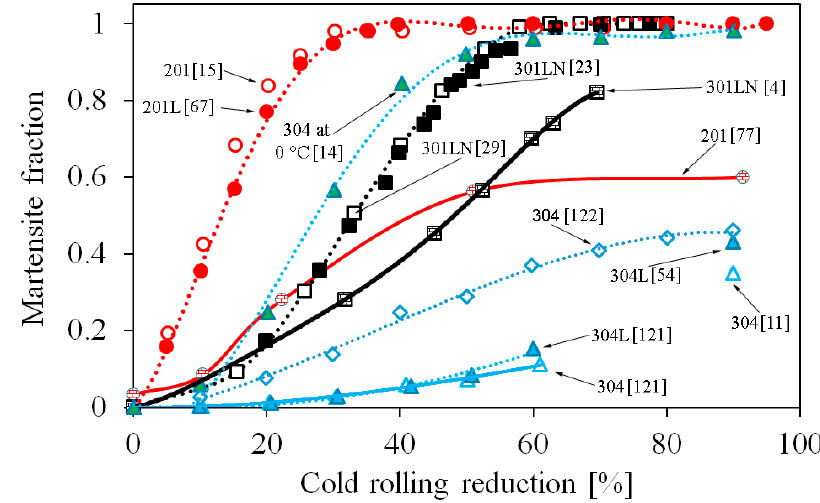
Figure 2. Examples of increase of the deformation-induced martensite fraction during cold rolling deformation in 201 / 201L, 304 / 304L and 301LN grades. The chemical compositions of the steels are in